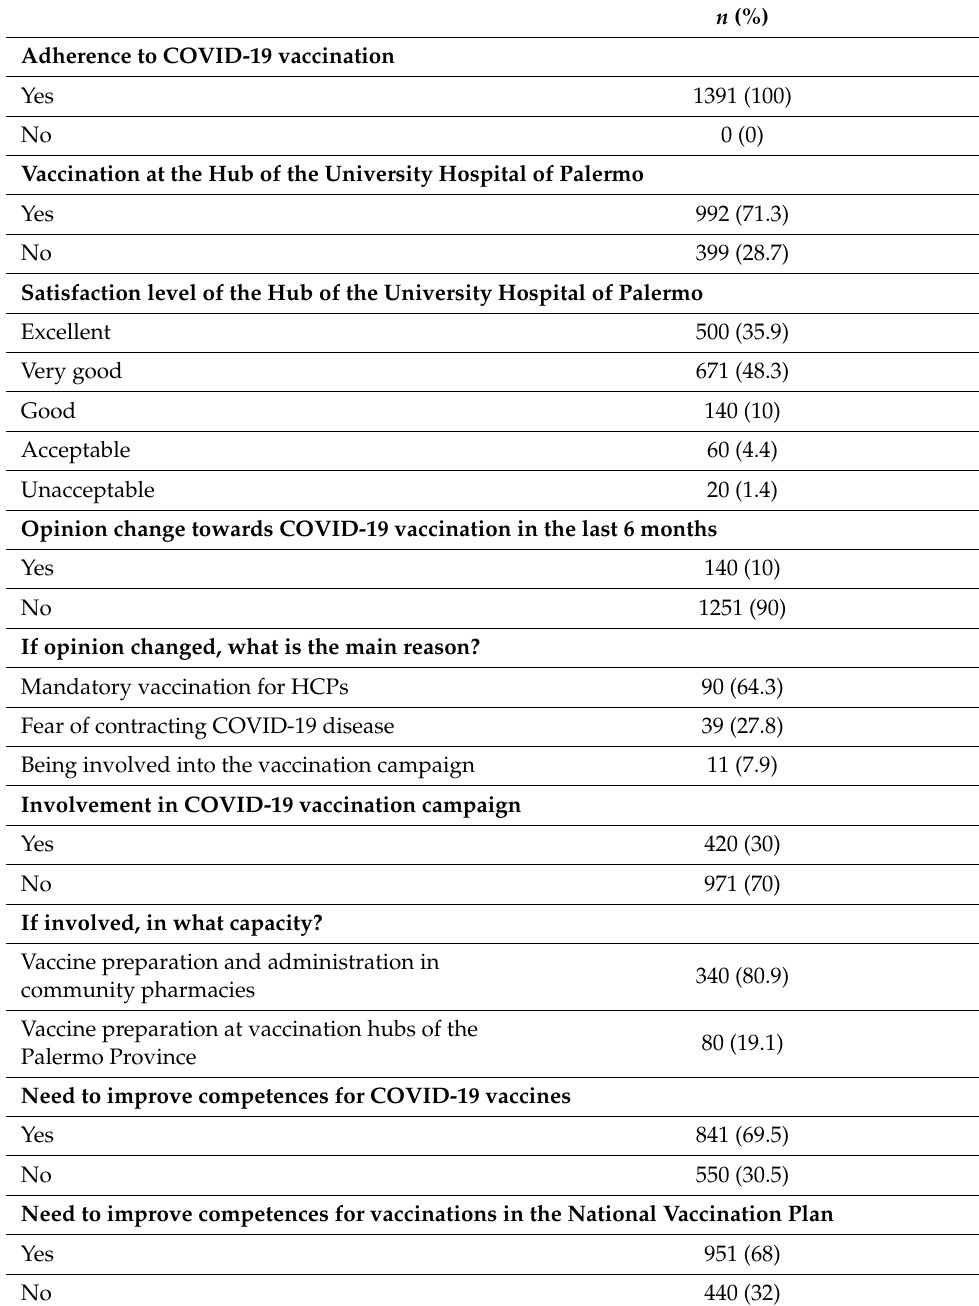
Table 5. Knowledge, attitudes, and perceptions regarding COVID-19 vaccination in the supplemen- tary survey administered during October 2021 ( n =